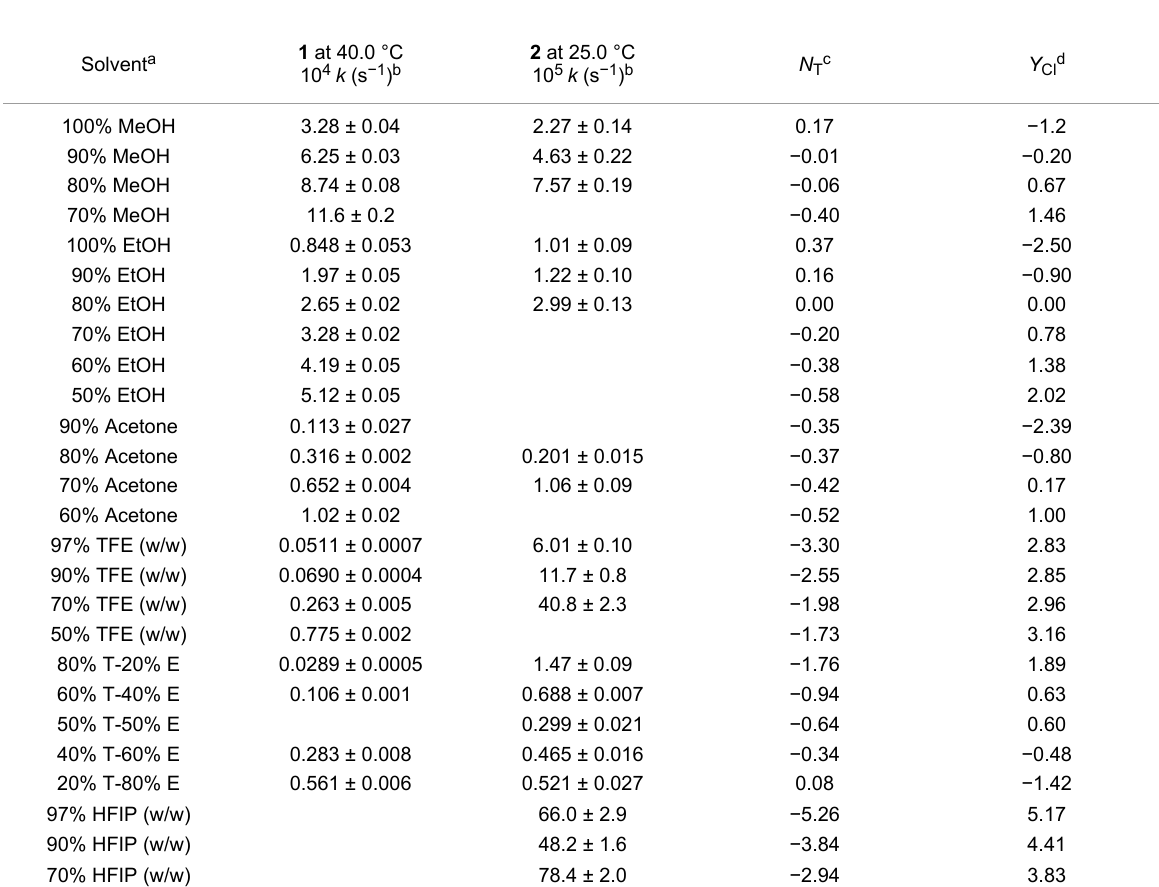
Table 1: Specific rates of solvolysis ( k ) of isobutyl chloroformate ( 1 ) and isobutyl chlorothioformate ( 2 ), in several binary solvents and literature values for N T and Y Cl